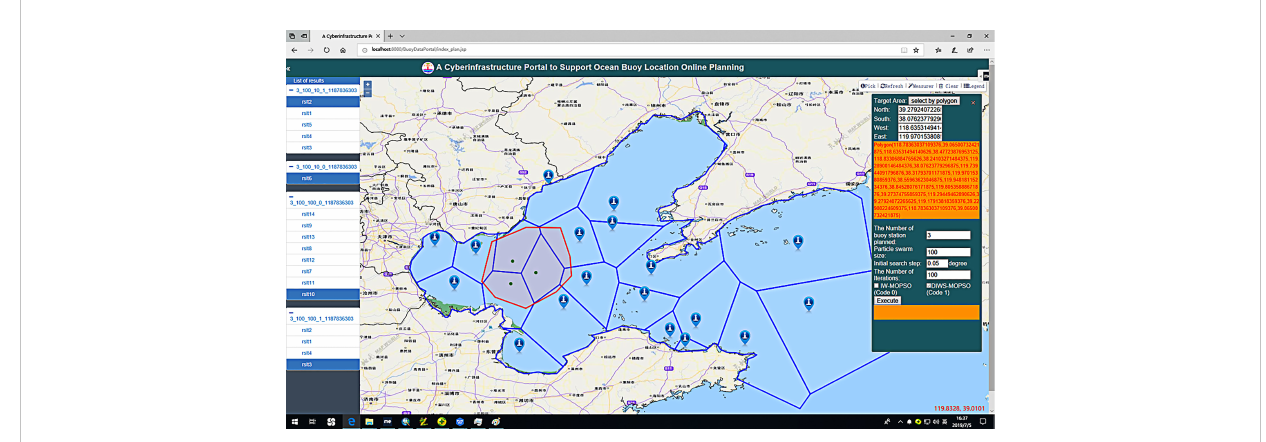
FIGURE 8 Screenshot of a cyberinfrastructure portal aggregating the SNM, the ocean buoy location model and the algorithms of IW-MOPSO and DIWS- MOPSO to support ocean buoy layout